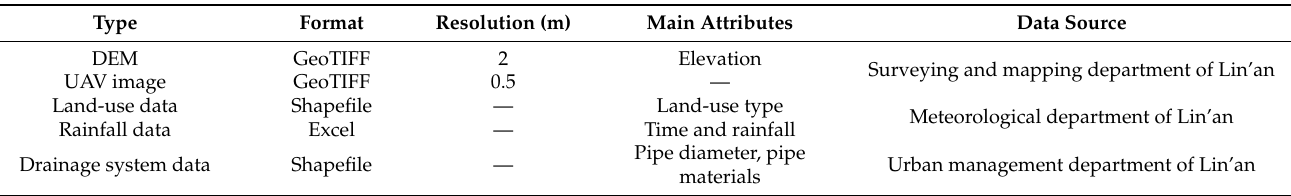
Table 1. List of geographic data in the study